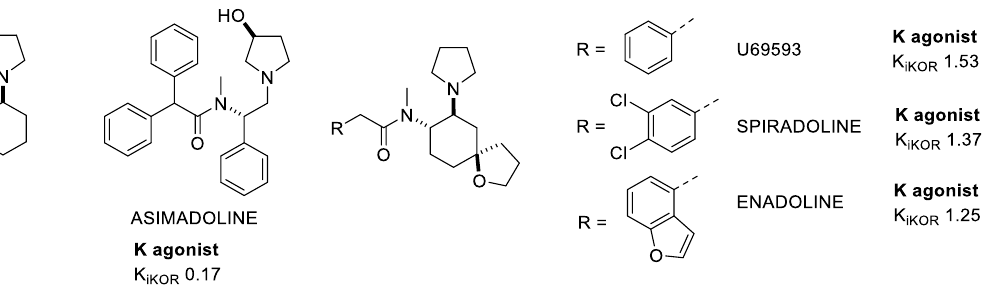
Figure 2. Examples of Arylacetamide KOR agonists. K i values are also shown (nM).